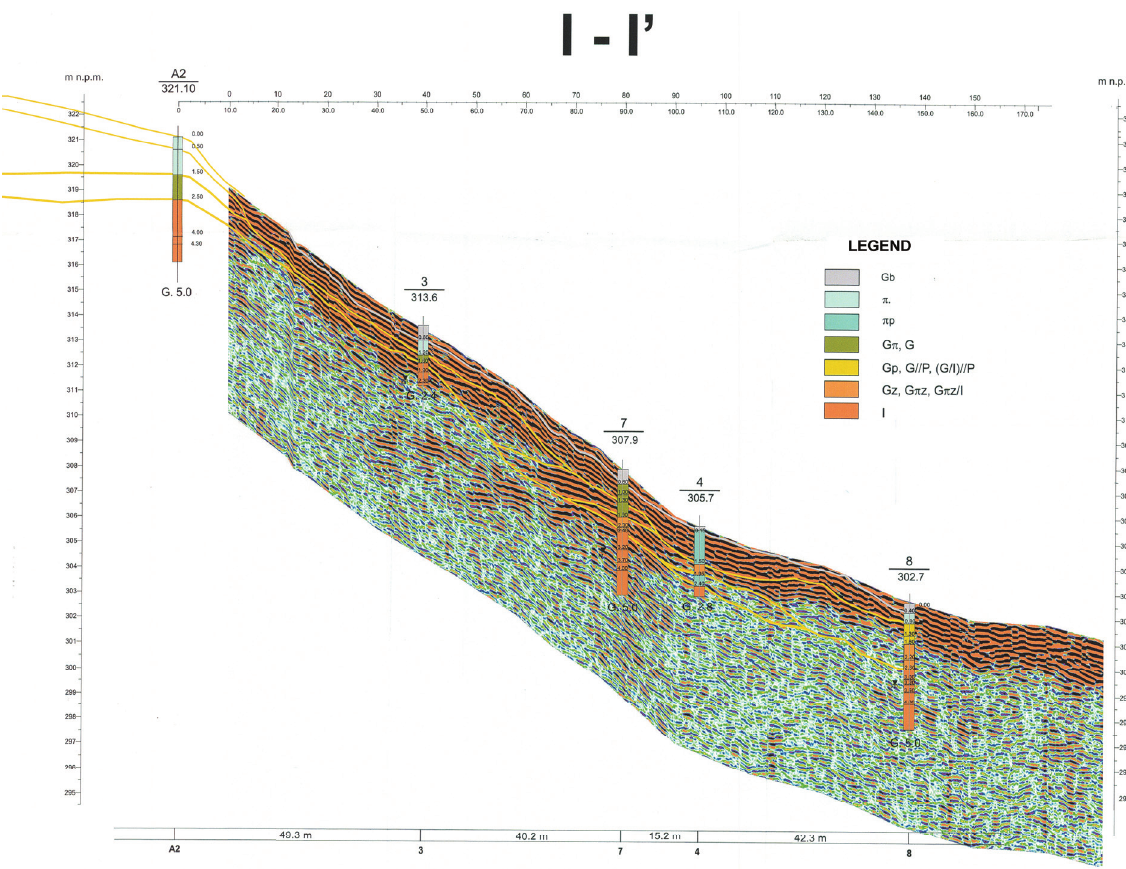
Fig. 7. The course of specific lithological